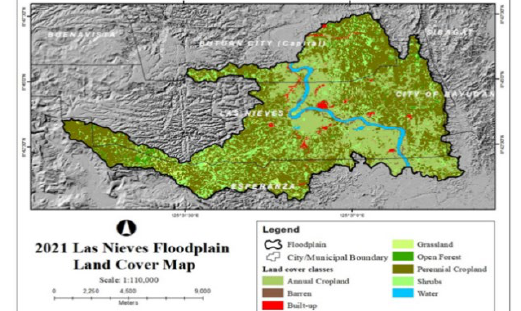
Figure 3. The 2021 Las Nieves floodplain land cover map.